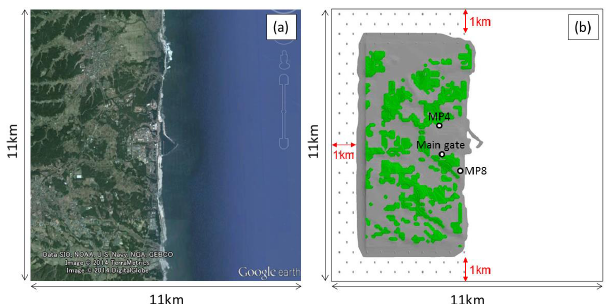
Figure 3. (a) The photograph reproduced by Google TM earth graphic. (b) Configuration of the FDNPP in the LES model. The buffer zone with 1.0km is set up from each boundary. In the land area of this buffer zone, roughness blocks are placed. Green area indicates forest canopies.